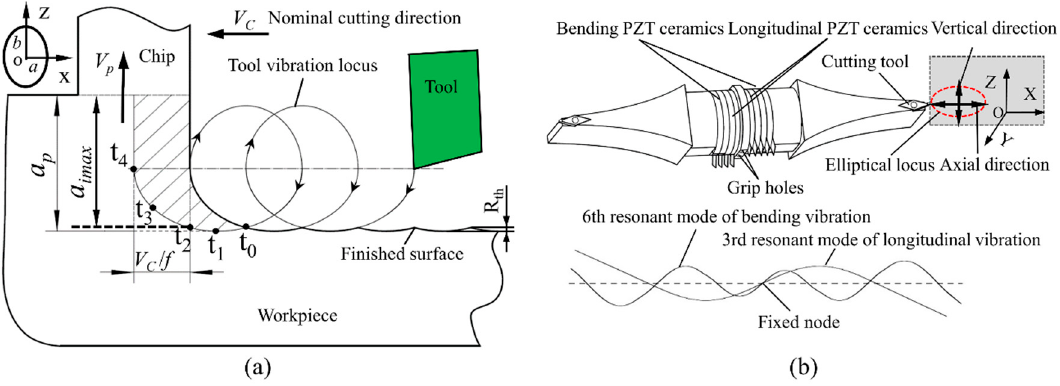
Figure 2. ( a ) Illustration of the ultrasonic elliptical vibration assisted cutting (UEVC) process, ( b ) ( b ) Schematic diagram of the UEVC Schematic diagram of the UEVC device.